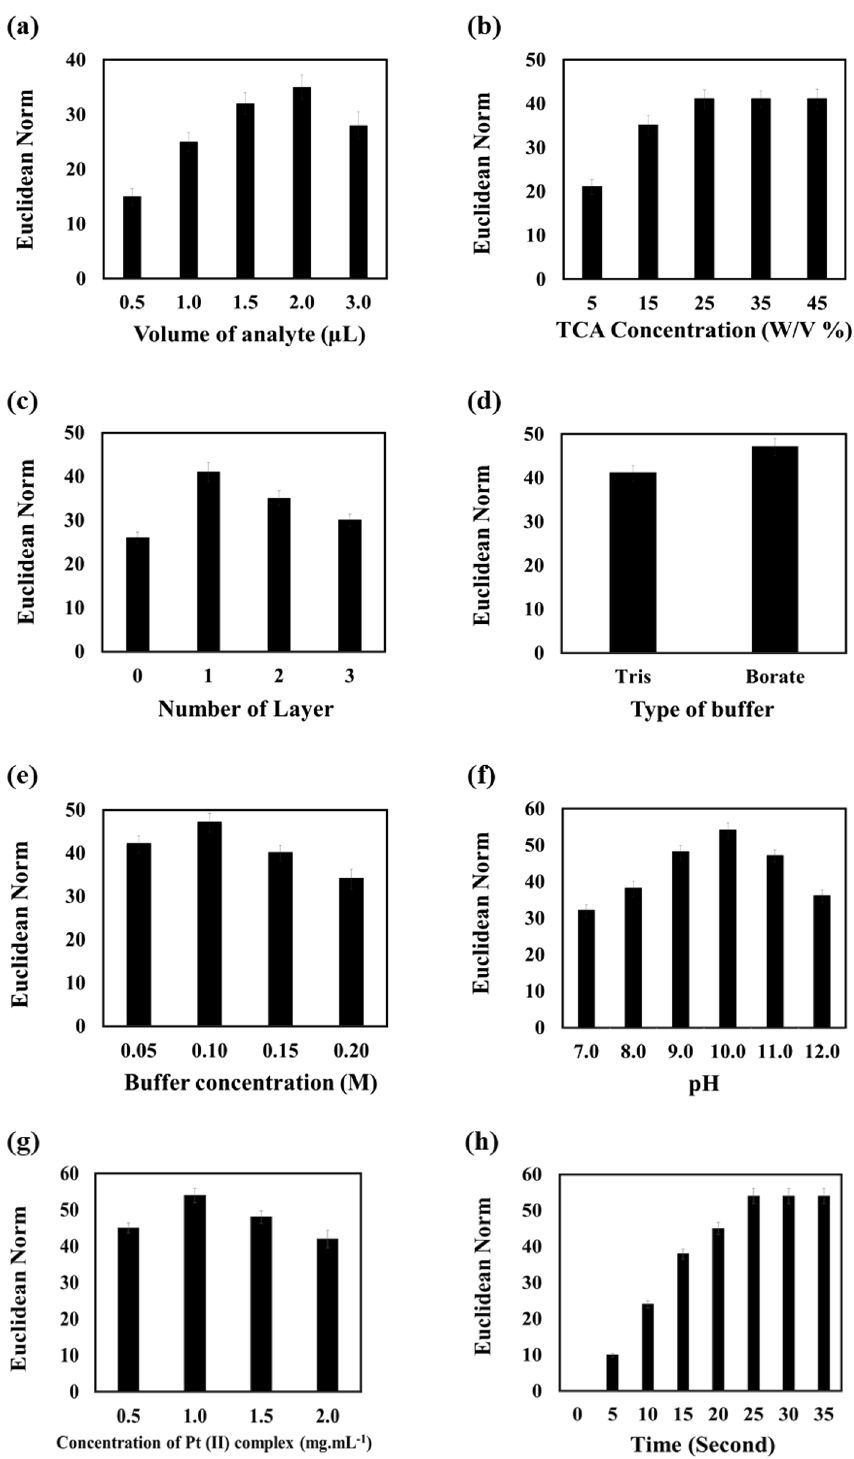
Figure 2. The effect of parameters including ( a ) volume of analyte, ( b ) TCA concentration, ( c ) number of gas collection layer, ( d ) type of buffer, ( e ) concentration of buffer, ( f ) pH of alkalization zone, ( g ) concentration of Pt (II) complex as receptor and ( h ) time of reaction on the response of sensor. The results were achieved in the presence of cyanide ions with the concentration of 40.0 µmol L −1